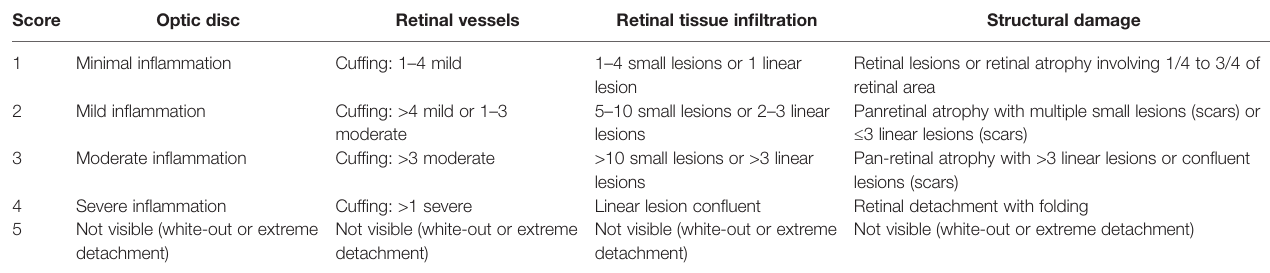
TABLE 1 | Scheme for scoring clinical ocular in fl ammation.